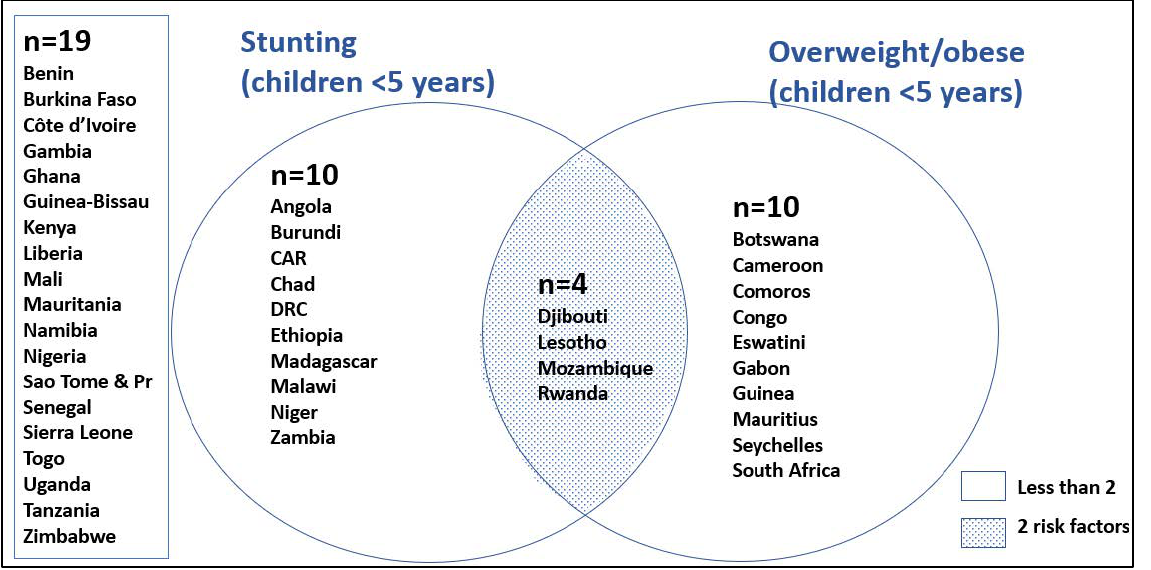
Figure 6. A Venn diagram showing SSA countries lying in the top tertiles for under five child stunting and child overweight (only those in the top tertile are in the diagram). Sao Tome & Pr: Sao Tome and Principe.